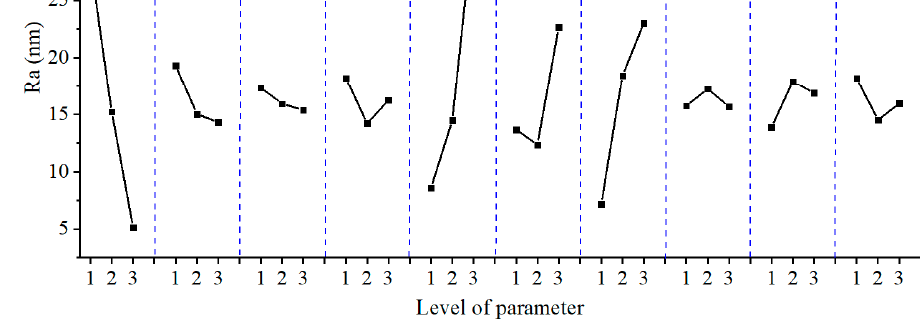
Figure 6. The effect plot for Ra.